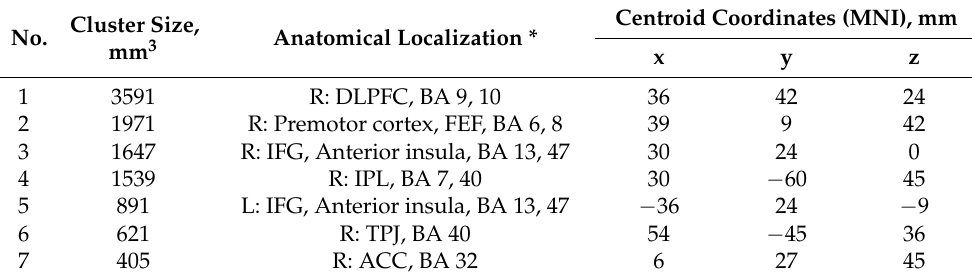
Table 1. Nodes of the non-selective response inhibition system in patients with OCD. Overlap of the results from a meta-analysis of 20 fMRI studies (“50/50% Go/NoGo > 100% Go control”) and Bayesian analysis of obtained fMRI data from OCD patients (“NoGo =